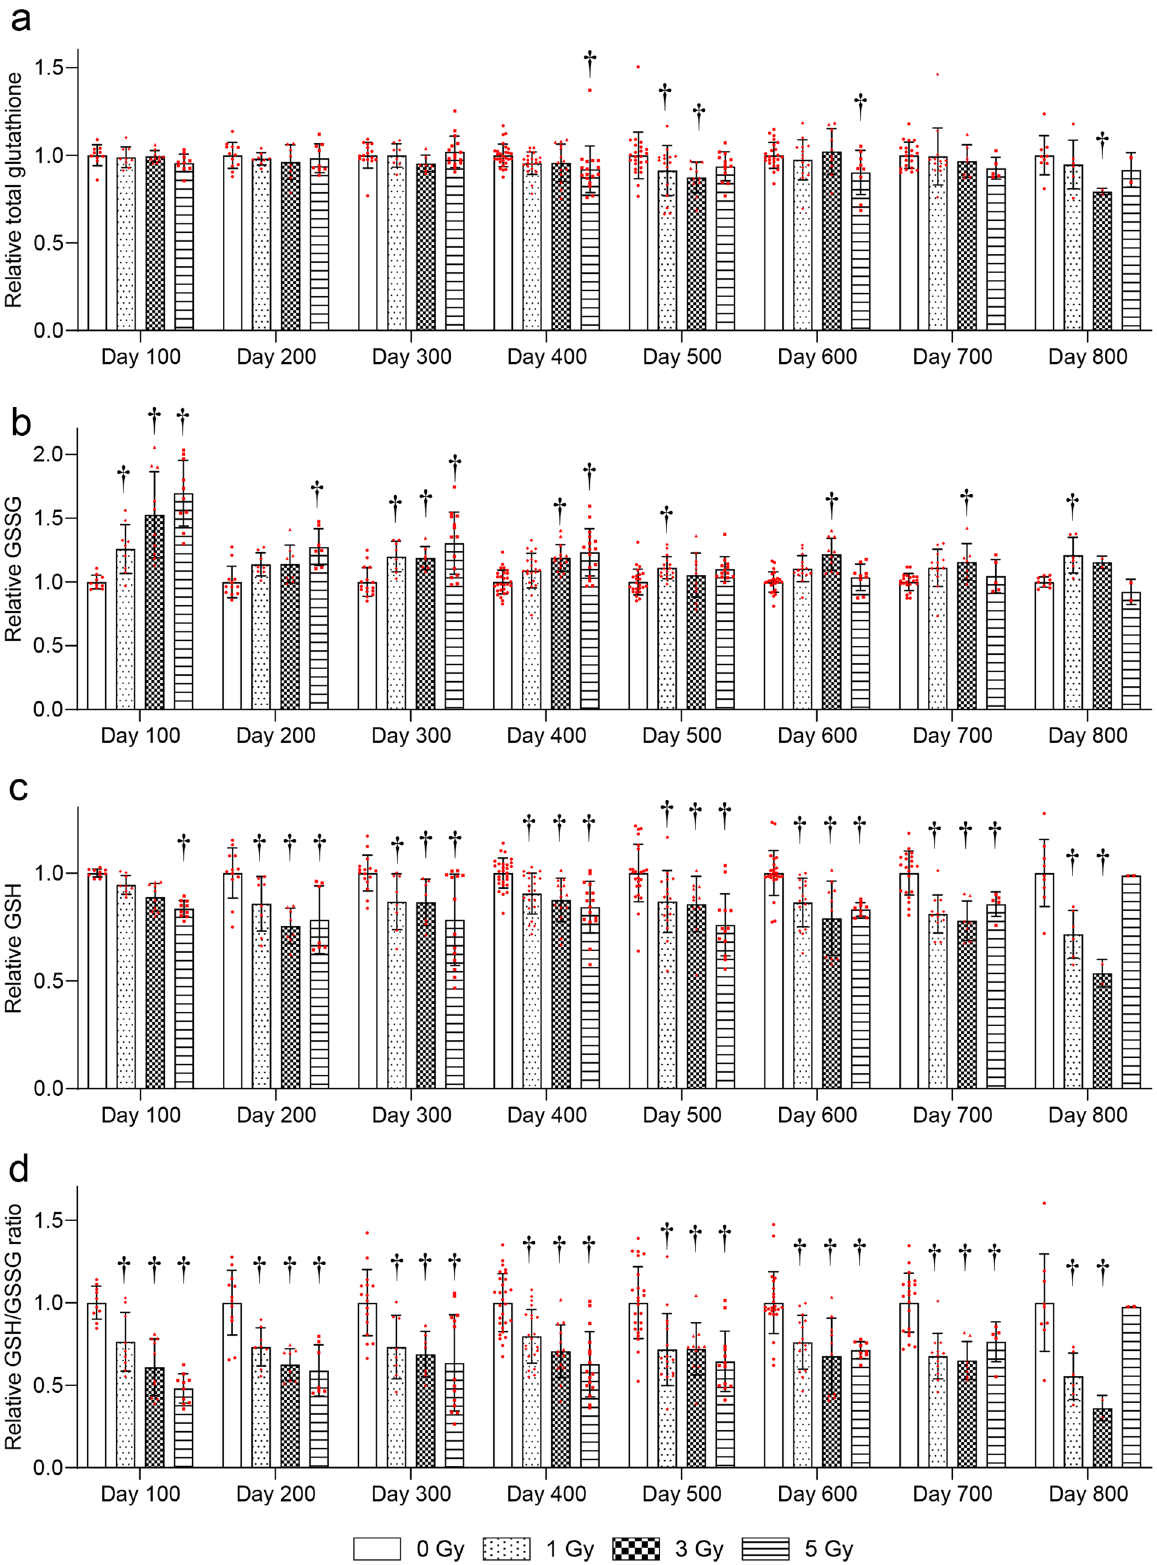
Figure 2. Changes in red blood cell (RBC) glutathione levels more than 100 days after TBI. Changes in ( a ) total glutathione, ( b ) reduced glutathione (GSH), ( c ) oxidized glutathione (GSSG), and ( d ) the GSH/GSSG ratio in RBC after irradiation. Bars indicate the means, error bars indicate the SDs, and red dots indicate individual data points. Two-way ANOVA and the post hoc Dunnett’s test were used to analyze significant differences with the 0-Gy group. † Indicates P <